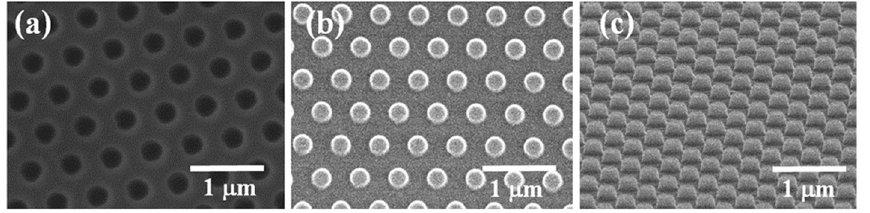
Figure 2. FE-SEM images of ( a ) Si master, ( b ) PFPE mold, and ( c ) tilted view of PFPE mold.